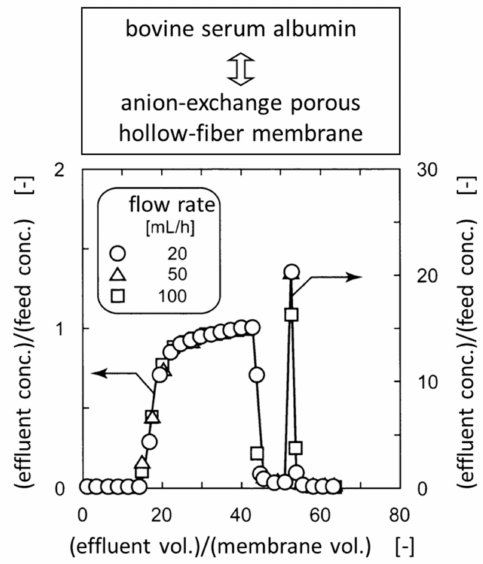
Figure 7. Dimensionless breakthrough and elution curves of anion-exchange porous hollow-fiber membrane for bovine serum albumin